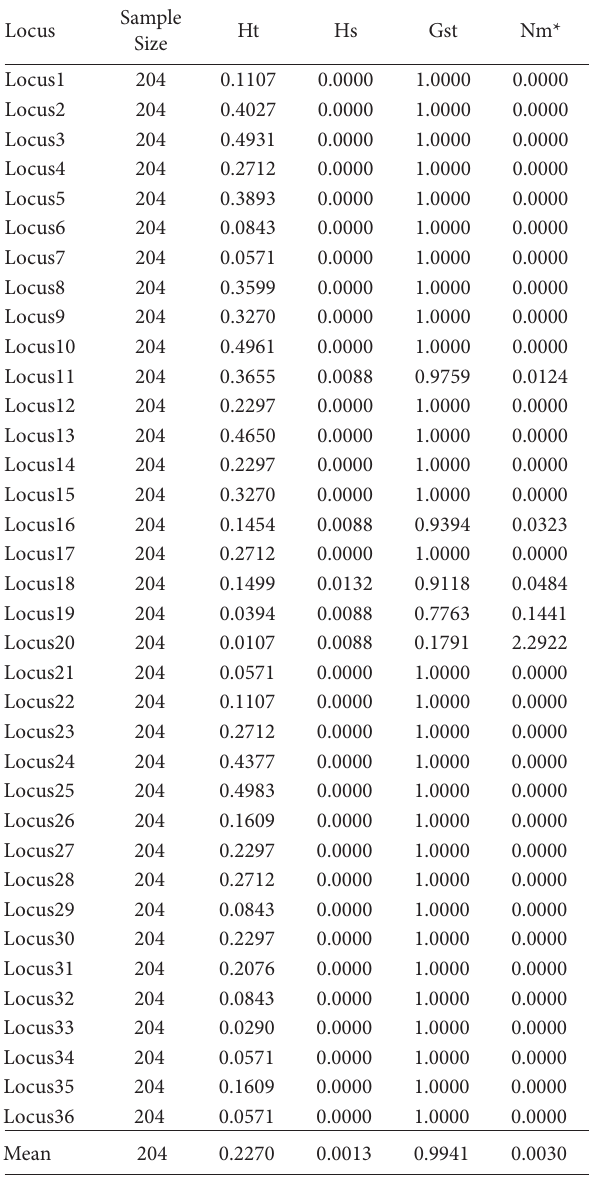
Table 3. Discrimination power of ISSR loci in studied Cousinia